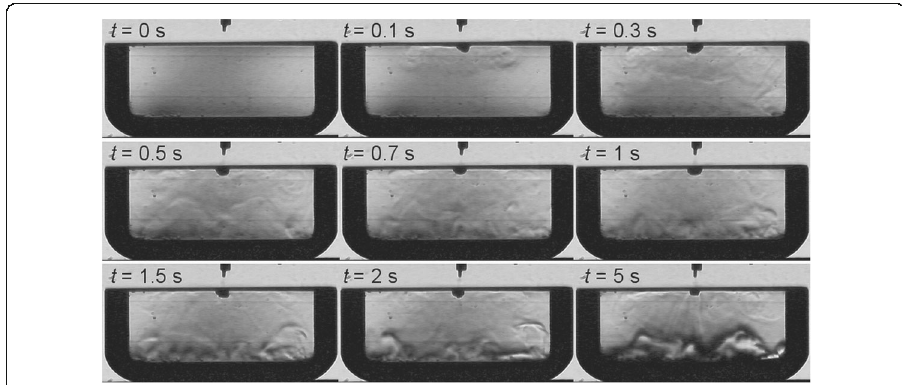
Fig. 4 Thermal field in water due to APPJ impingement, measured by schlieren imaging. At t = 0 s the plasma discharge was initiated. The APPJ nozzle is shown at top center of each image [55] © Deutsche Physikalische Gesellschaft. Reproduced by permission of IOP Publishing. CC